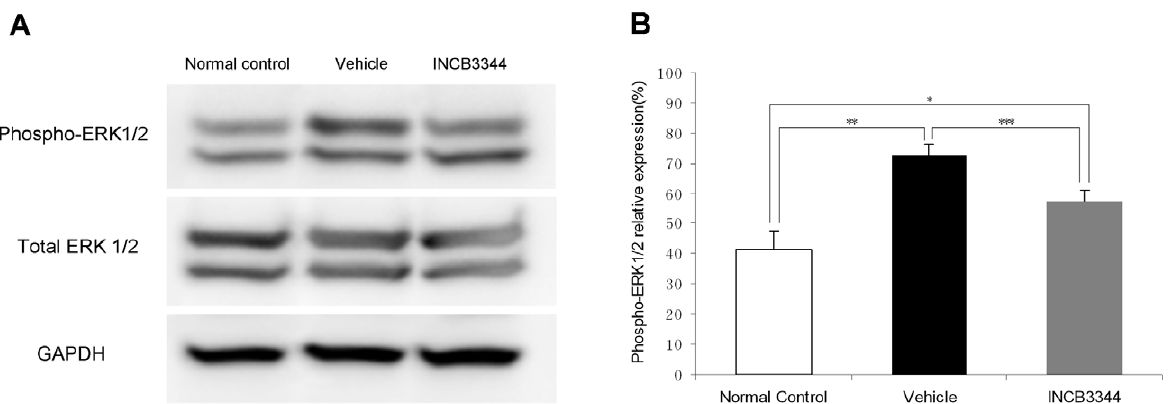
Figure 4. Phosphorylated extracellular signal-regulated kinase (p-ERK1/2) expression in Western blot. ( A ) A representative blot. p-ERK expression in the choroid-RPE complex from vehicle-treated mice and INCB3344-treated mice on Day 3 after laser photocoagulation, and normal mice (without photocoagulation). Western blot analysis revealed that p-ERK expression increased after laser photocoagulation and was suppressed by INCB3344 treatment. ( B ) Semi-quantitative analysis of the band intensity showed an increase in relative p-ERK expression (values normalized to total ERK expression) in the eyes of photocoagulated mice compared with untreated mice( n =8, * P , 0.001; n =8, ** P , 0.001), and INCB3344 suppressed this increase ( n =8, *** P ,